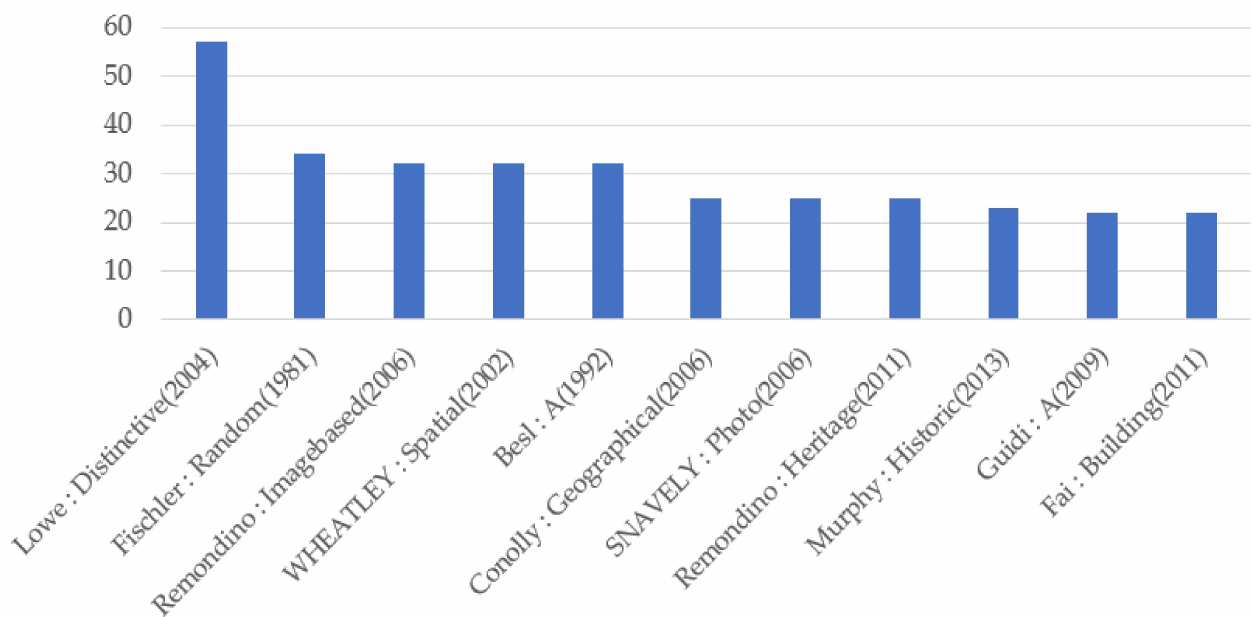
Figure 10. What are the most cited publications? (Publications with more than 20 citations from n = 51,789 references out of 3391 articles).